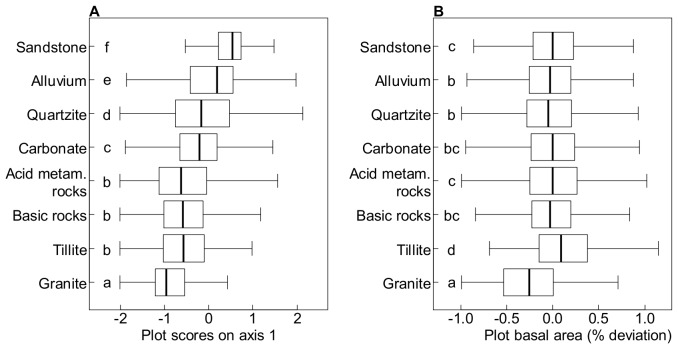
Compositional and structural differences among forests growing on different geological substrates.Plot scores on the first compositional axis were used to describe the main variation in species composition (A). Structural differences were assessed as the % deviation from mean plot basal area (B). Significant differences between substrates at P<0.001 in paired Wilcoxon tests are indicated by different letters.